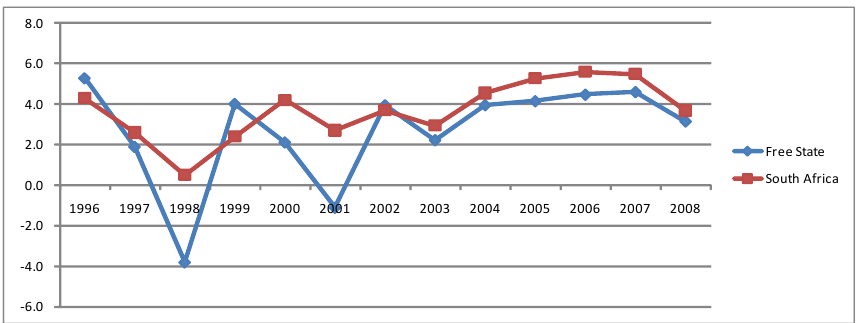
FIGURE 1: GDP growth in Free State and South Africa (%) - Pre-crisis Source: Statistics South Africa